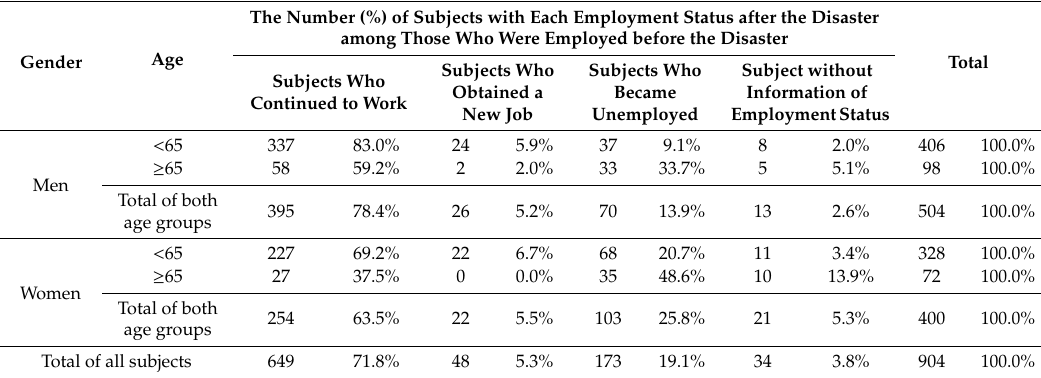
Table 2. Employment status of subjects after the Great East Japan